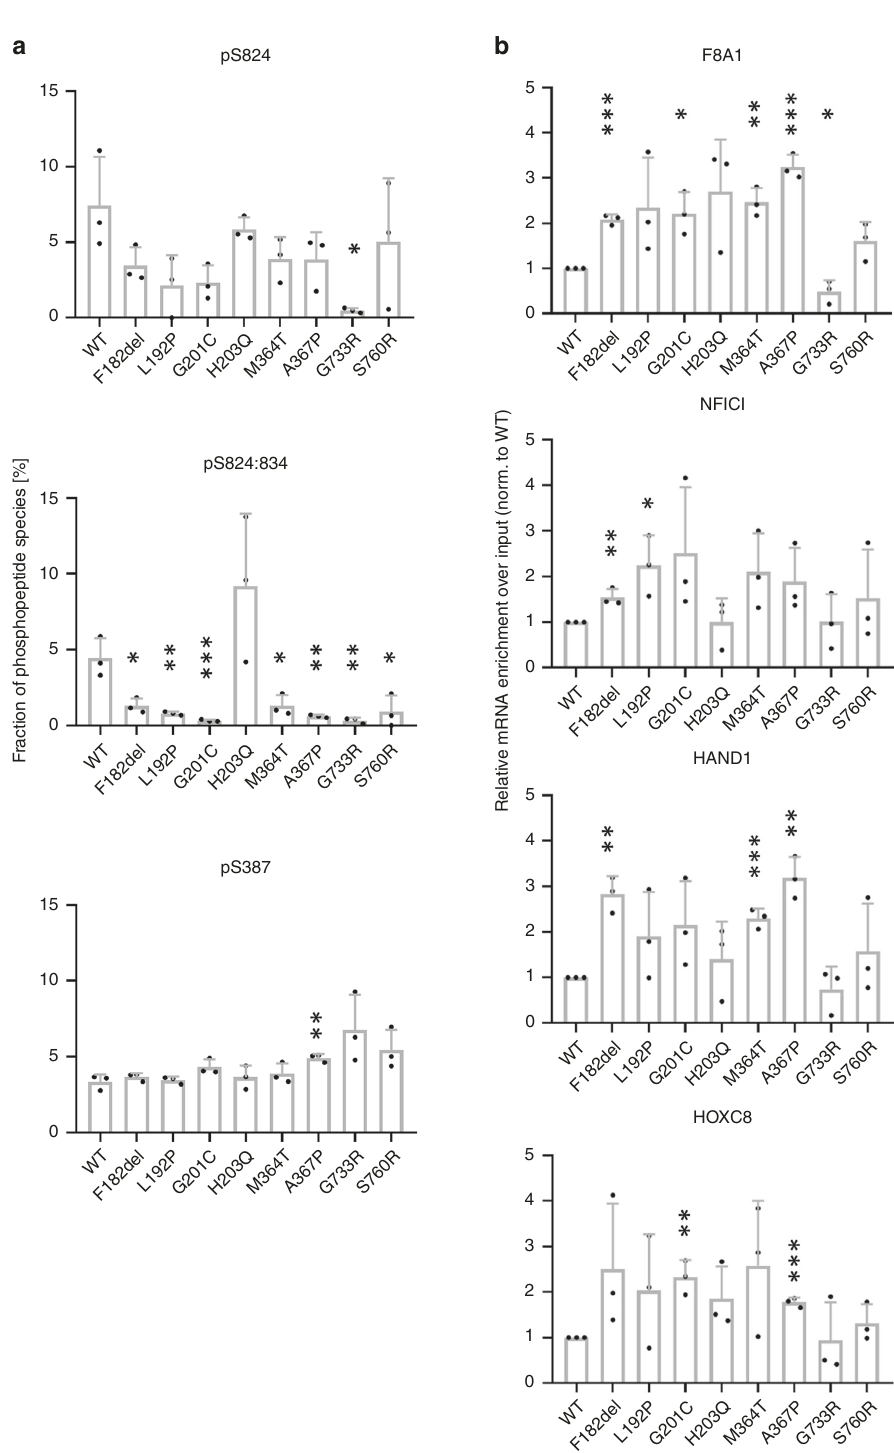
Fig. 3 Reduced target dissociation of AGO2 germline mutants. a 293 cells were transfected with F/H-tagged AGO2. After immunoprecipitation, phosphorylation of S824 alone, of the S824 – S834 cluster and of S387 was measured by a targeted quantitative mass spectrometry approach (Selected reaction monitoring with isotopically labeled spike-in peptides). The y -axis represents the percentage of individual phosphorylated peptide species assuming the sum of singly, multiply and non-phosphorylated peptides to be 100%. Signi fi cance was assessed by two-sided Student ’ s t test in relation to WT. n = 3 biologically independent experiments. Data are presented as mean + SD. *, **, *** p < 0.05, 0.01, 0.001, respectively. b RNA was isolated from F/H – AGO2 immunoprecipitates and analyzed by qRT-PCR using primers for the genes indicated. The signi fi cance was assessed by two-sided Student ’ s t test in relation to WT. n = 3 biologically independent experiments. Data are presented as mean + SD. *, **, *** p < 0.05, 0.01, 0.001, respectively. Source data are provided as a Source Data fi